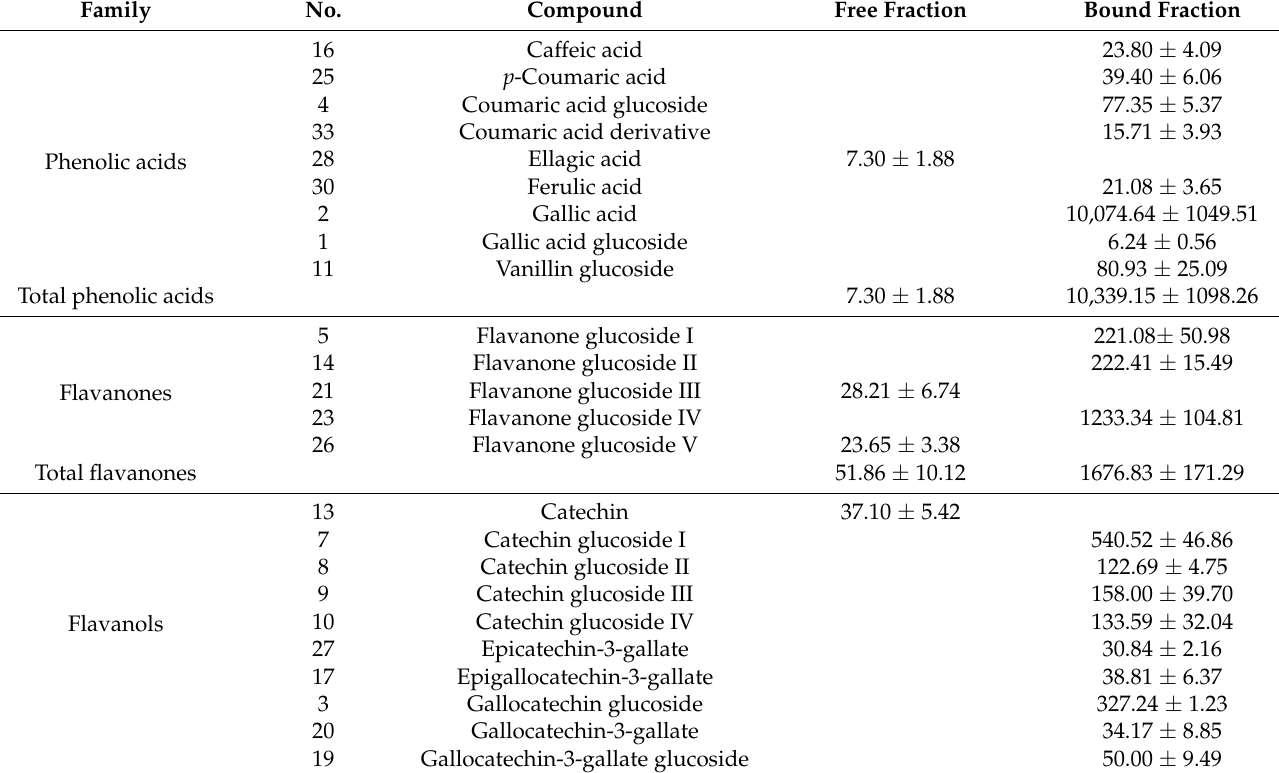
Table 2. Free and Bound polyphenolic compounds ( µ g/g dry weight) of the persimmon flour. Family No. Compound Free